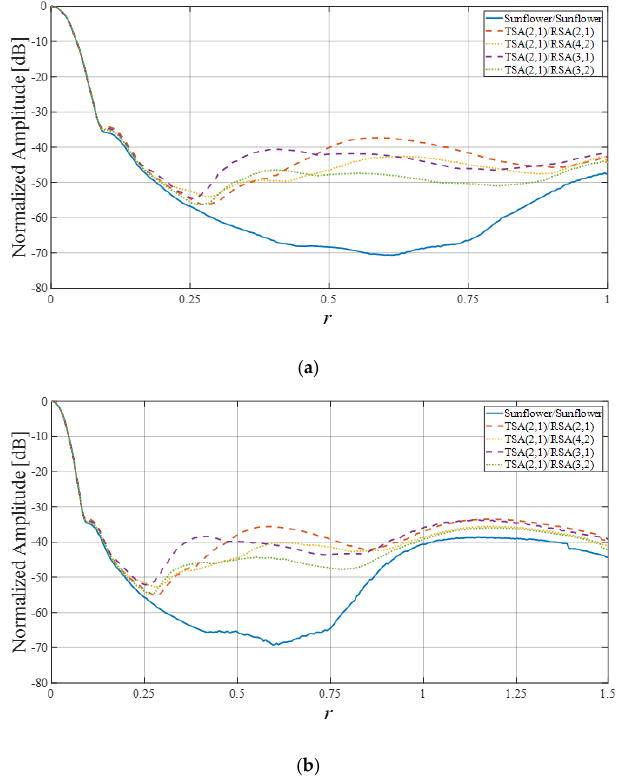
Figure 16. Peak 1D profiles of ( a ) non-steered and ( b ) steered PW PSFs of the spiral array pairs. For each r , the maximum value of the PSFs on the r -radius circle centered at the focal point is plotted. The steered focal point was set to ( u x f , u y f ) = (0.5,0) (i.e., θ f = π/6, and φ f = 0). Table 3. Properties of near-field, pulsed-wave responses of spiral array pairs.